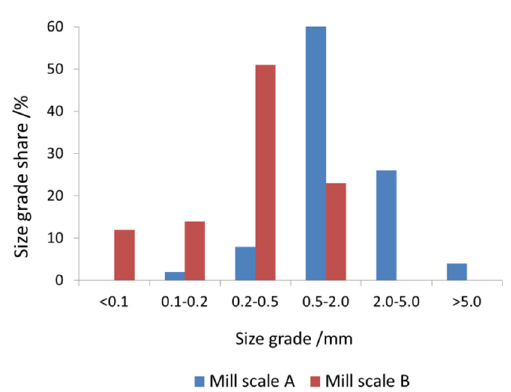
Figure 5. Size composition of A and B fractions of tested mill scale.